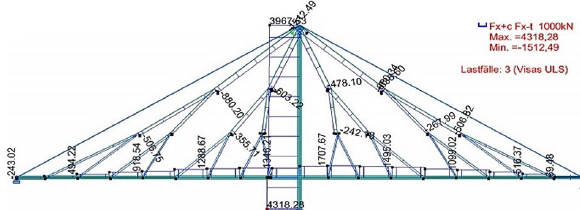
Figure 8. Diagram of the bending moments under asymmetric load